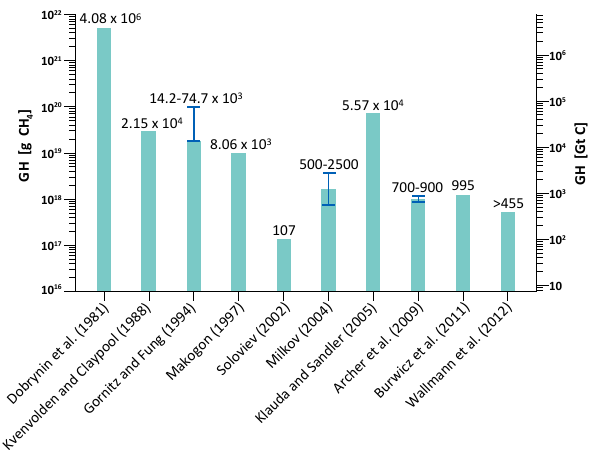
Fig. 1. Estimates of global gas hydrate inventories in marine sedi- ments. The corresponding estimated ranges are labelled in